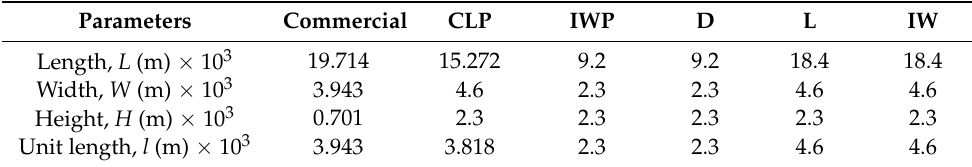
Figure 2. The relationship between the number of periodic units and pressure drop per unit length. Table 2. The size of computational domain with respect to various